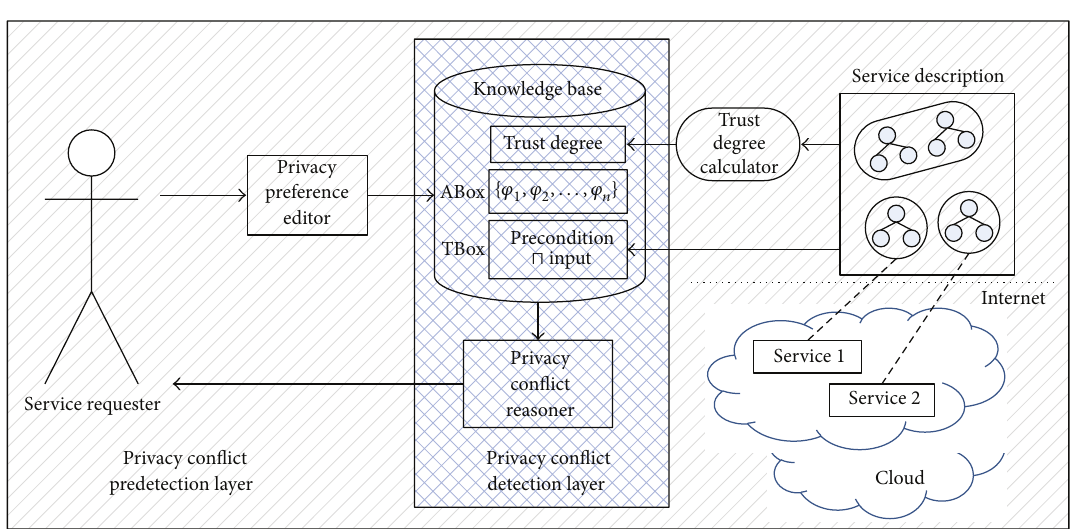
Figure 3: Framework of privacy conflict